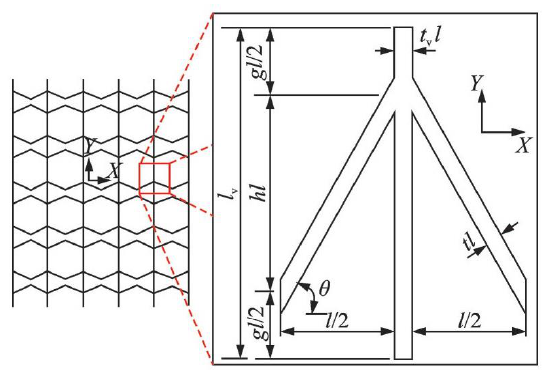
Figure 7. Accordion honeycomb structure parameters [24].